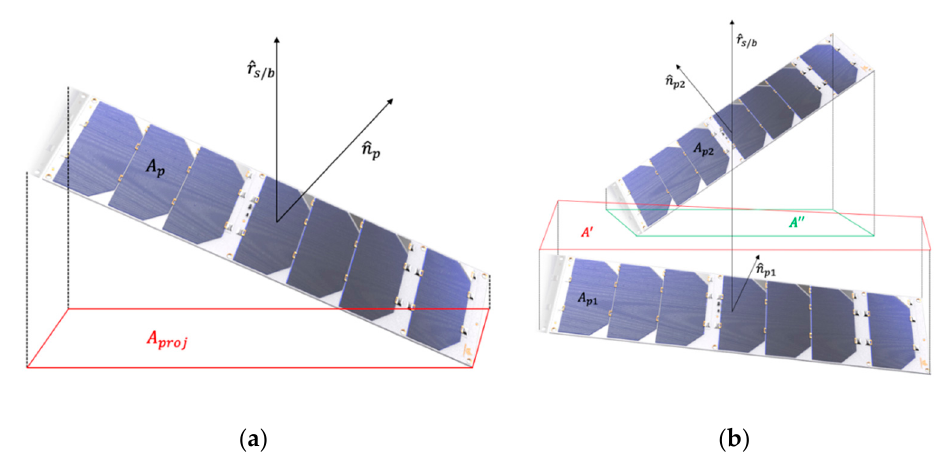
Figure 7. Solar panel projected area: ( a ) projected area of a single solar panel; ( b ) projected area of one panel onto another for shadow calculation.